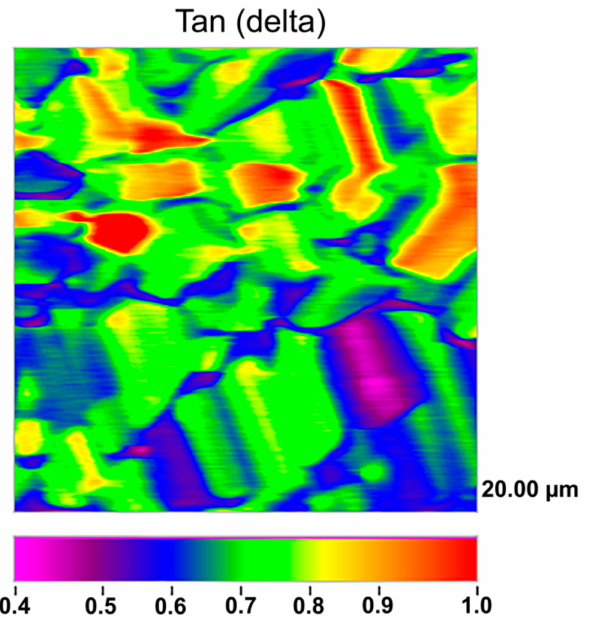
Figure 9. Nano-DMA analysis, on scanning mode, of the surface’s Zn-matrix. The property map corresponds to the tan delta